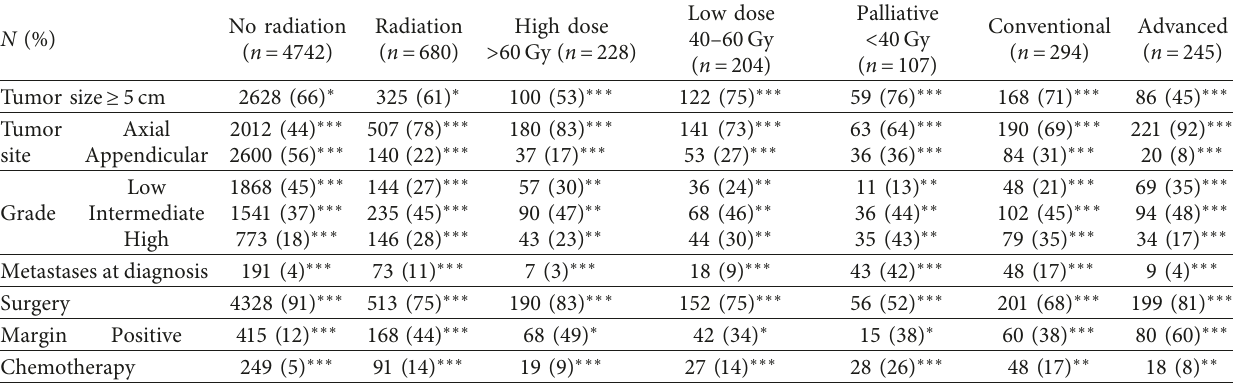
Table 2: Tumor and treatment